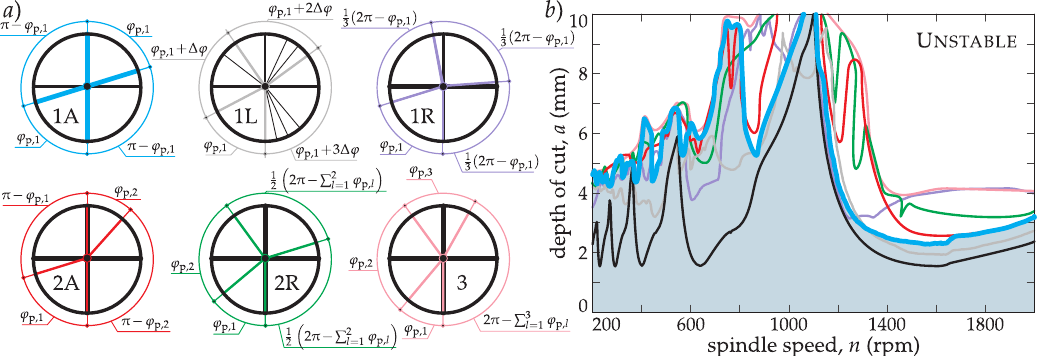
Figure 4. Panel ( a ) presents the different topologies that can be realized easily in a Z = 4 milling cutter. Panel ( b ) presents the stabilizability diagram (SYD) for the shown topologies. ϕ p,min = 70